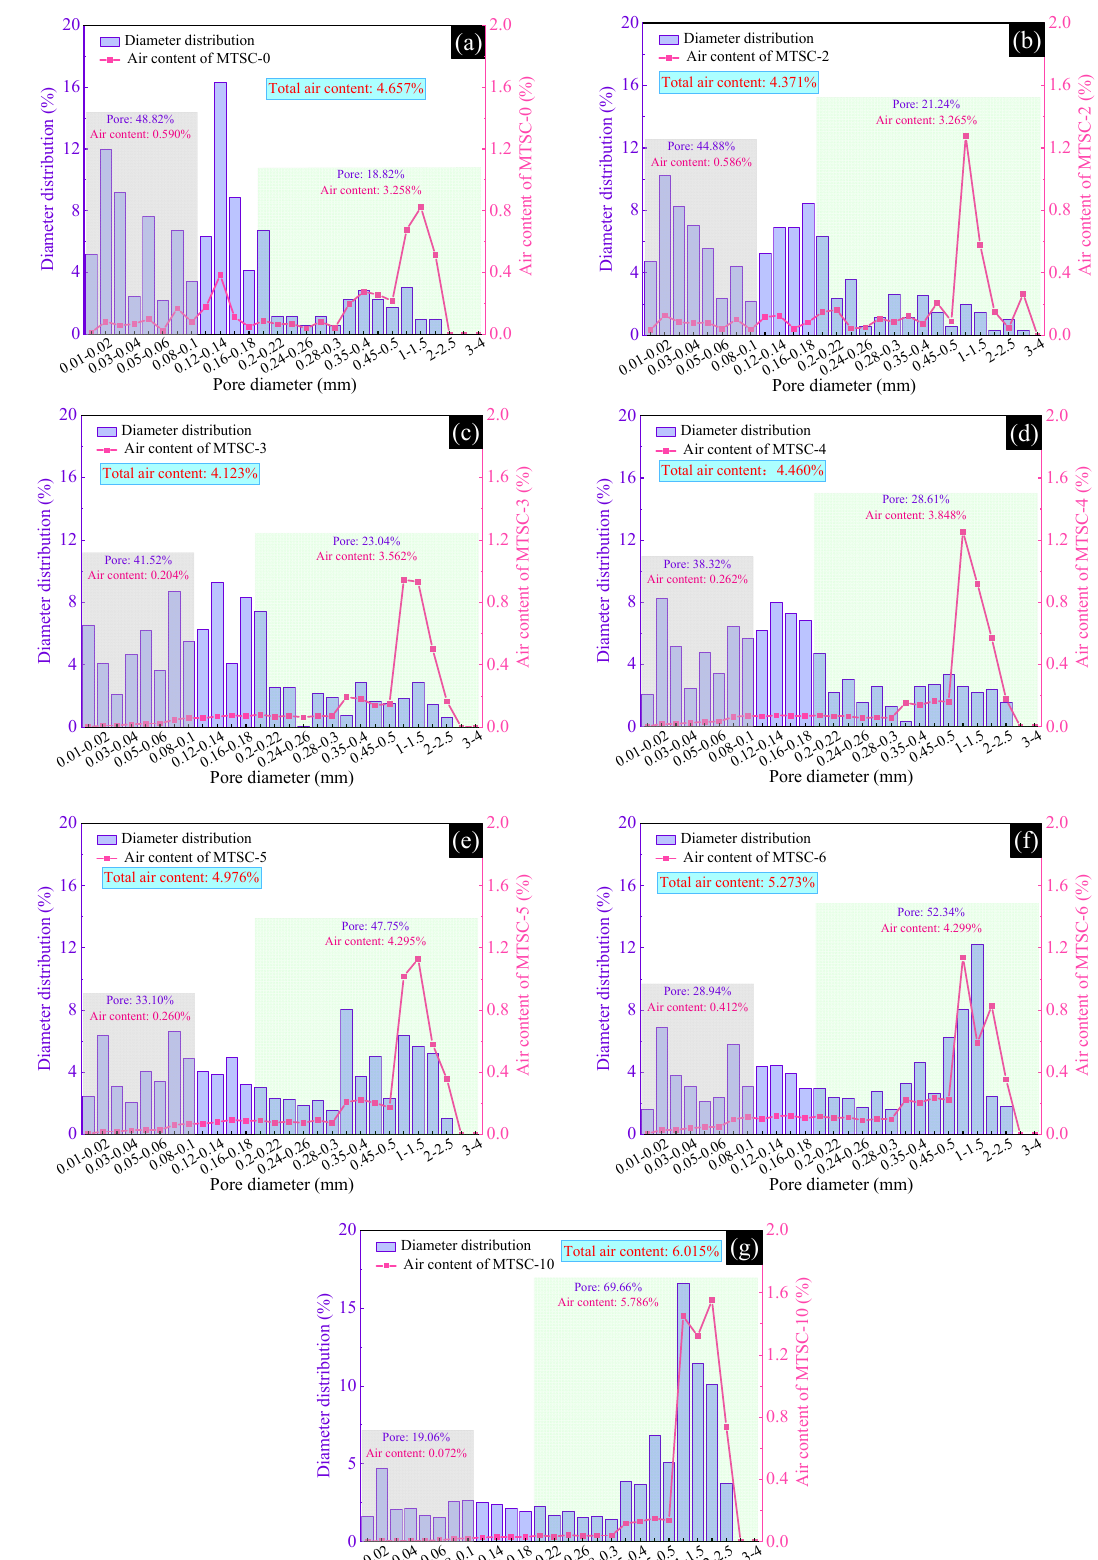
Figure 8. Pore diameter distribution and air content of MTSC. ( a ) MTSC-0, ( b ) MTSC-2, ( c ) MTSC- 3, ( d ) MTSC-4, ( e ) MTSC-5, ( f ) MTSC-6, ( g ) MTSC-10. ( d ) MTSC-4, ( e ) MTSC-5, ( f ) MTSC-6, ( g )